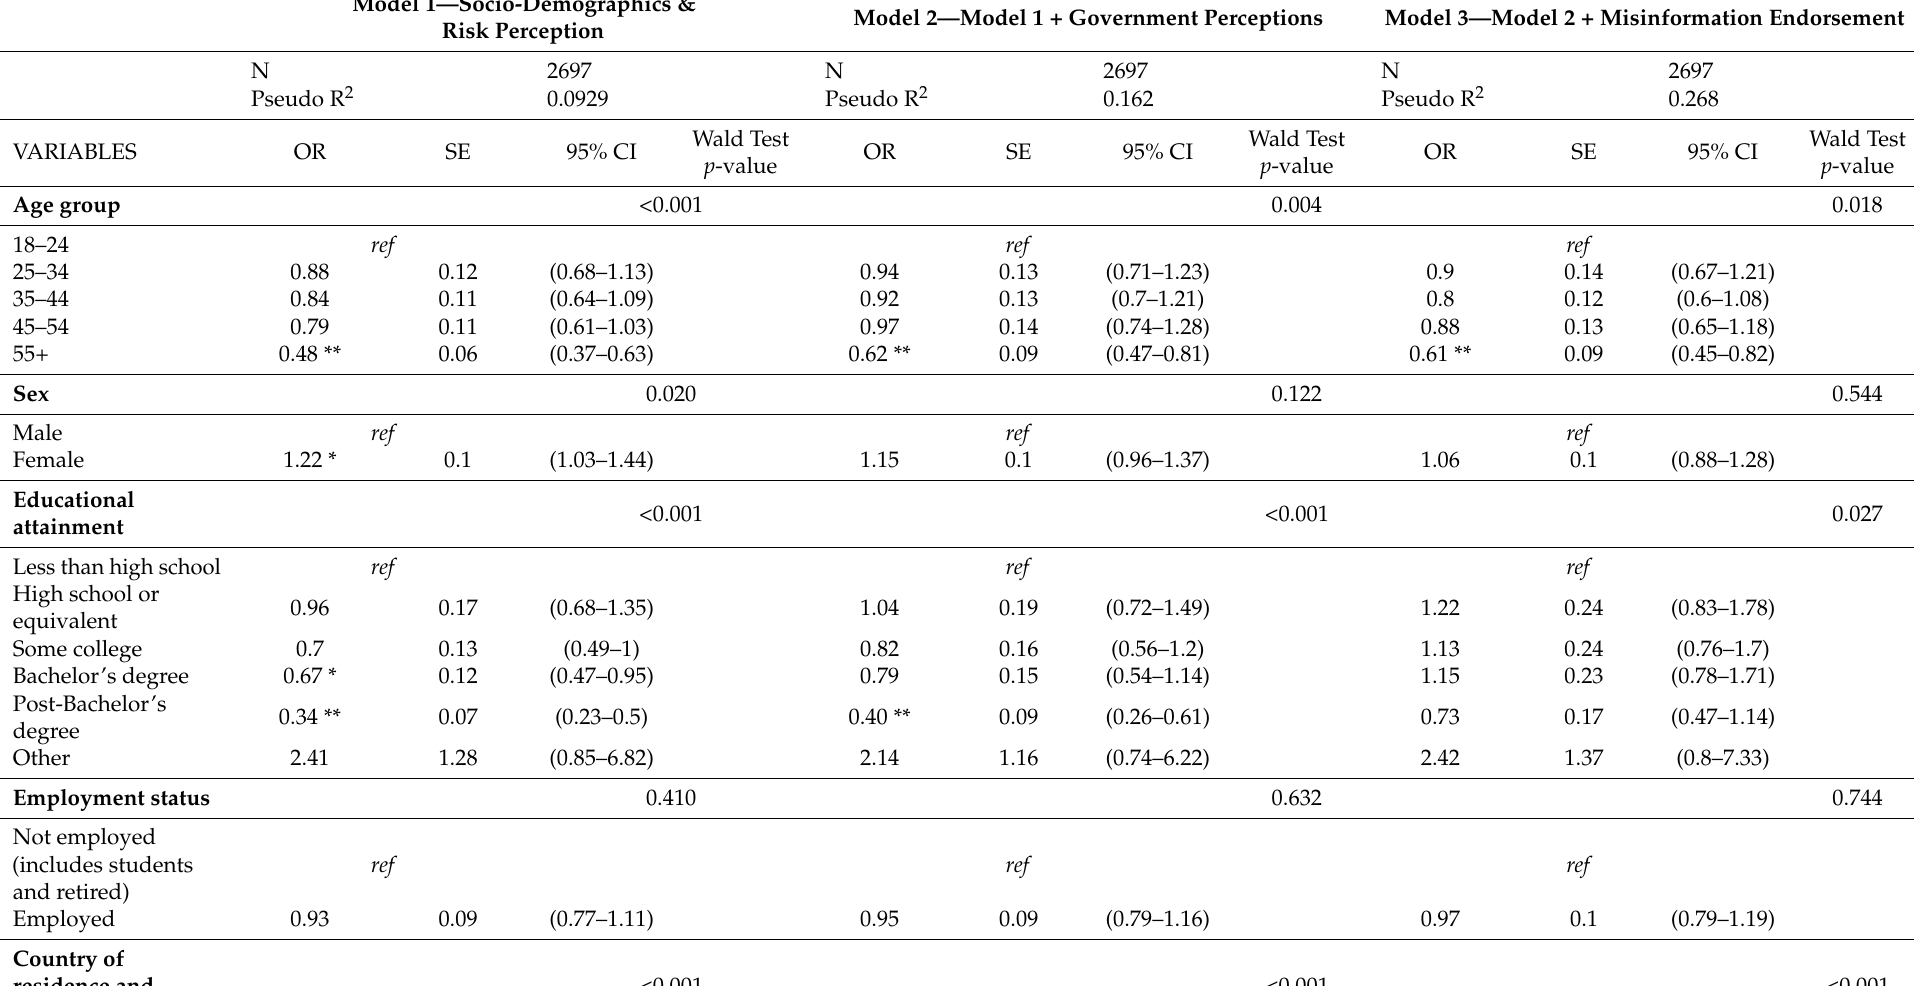
Table 2. Nested Logistic Regressions for Vaccine Hesitancy in the Overall Sample ( n =